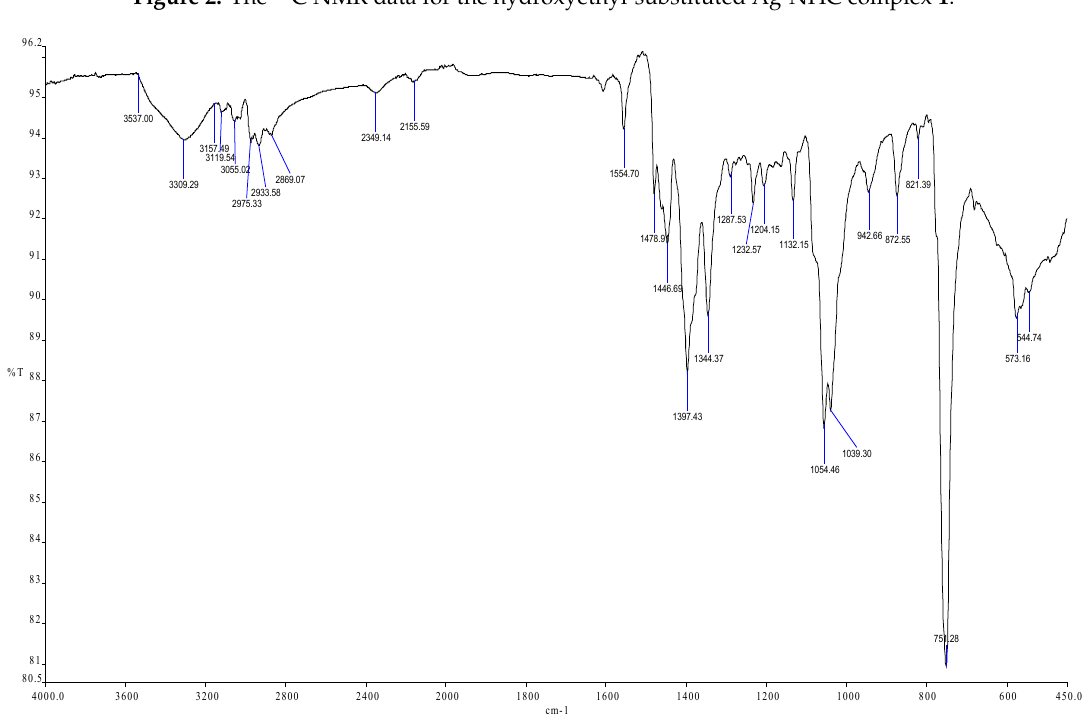
Figure 3. The FTIR spectrum of the hydroxyethyl-substituted Ag-NHC complex 1.